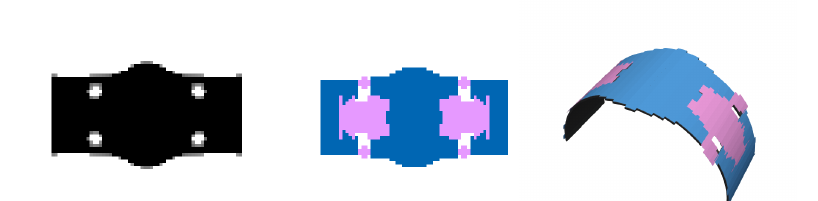
Figure 4. Structure layout ρ s ( left ), electrode profile ρ p ( centre ) and 3D design ( right ) for the third example.